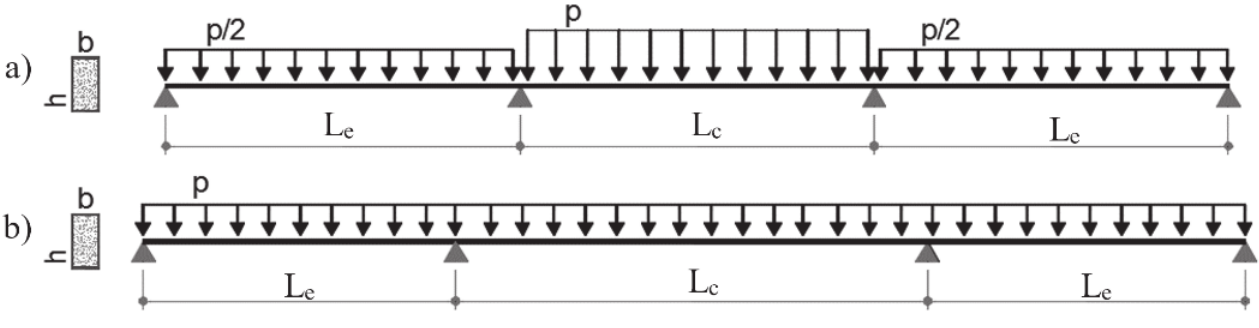
Loading patterns and variables used to define the geometry of three-span beams: a) groups VC3V-G1 and VC3V-G2; b) groups VC3V-G3 and VC3V-G4